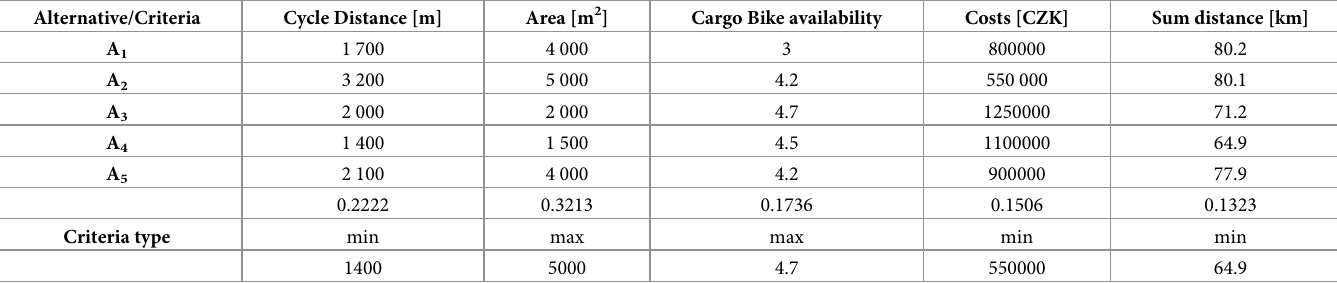
Table 17. The initial input data processed by the WASPAS method.